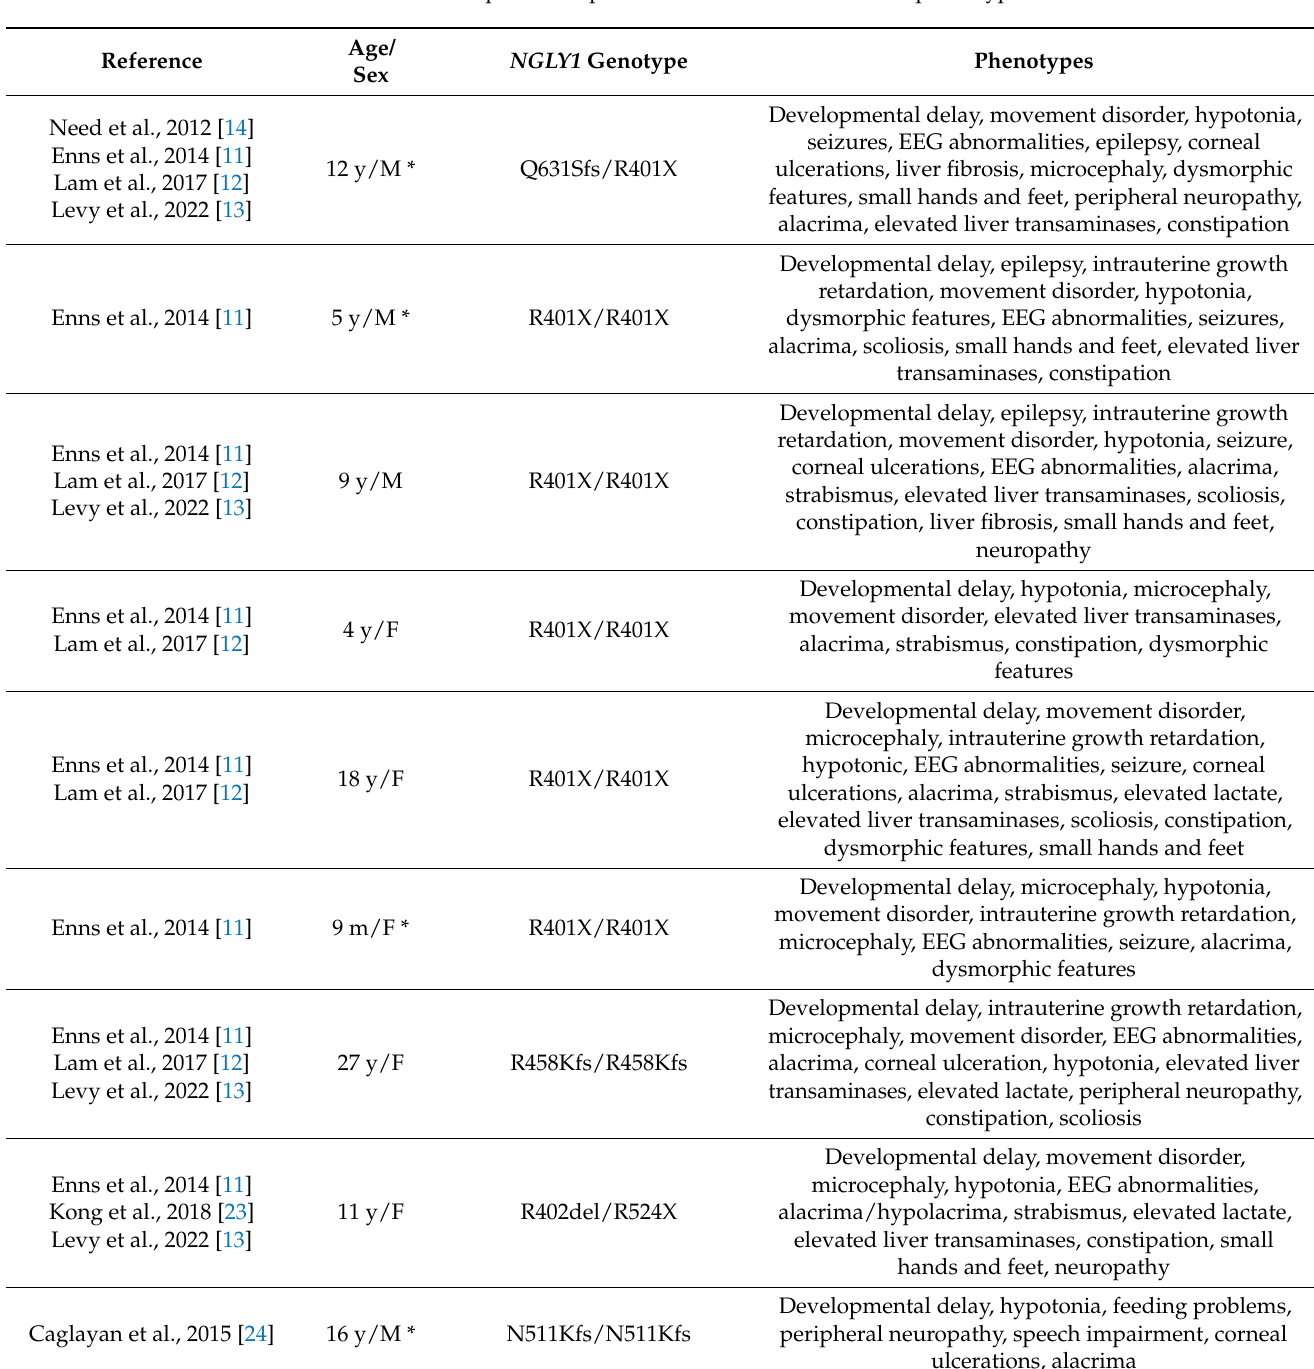
Table 1. List of patients reported in the literature and their